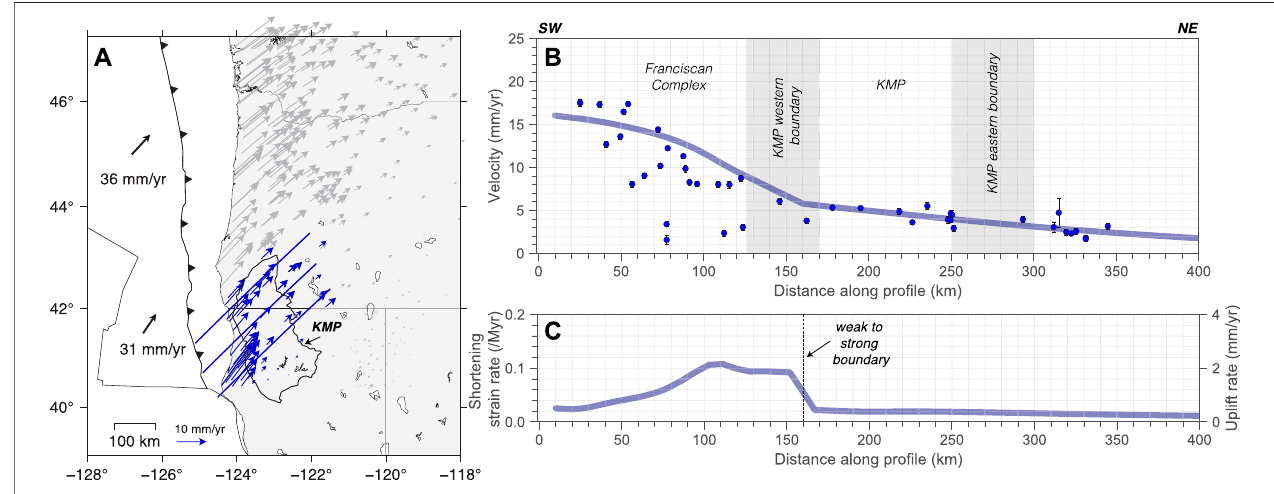
FIGURE6|(A) NE-directed(subductioncoupling)componentoftheGPSvelocity fi eldinthestudyregion.Data(bluevectors)sampledbytheNEtransects(westto east) shown are plotted in (B) . (B) Pro fi le through the NE-directed GPS velocity fi eld (pro fi les shown in (A) ). The blue transparent line is the synthetic GPS velocity model resultfora fi niteelementmodelwithanupper platecomposed ofweakmaterial(theFranciscancomplexandmodernaccretionarymargin)neartothetrench, andarigid backstop (the KMP) inboard. The weak to strong boundary in the model is at 160 km (the approximate distance of the KMP boundary from the trench). (C) Shortening strain rate derived from model velocity results in (B) . The uplift rate is based on the assumption of an average upper-plate thickness of 20 km (adapted from McKenzie et al., 2022).